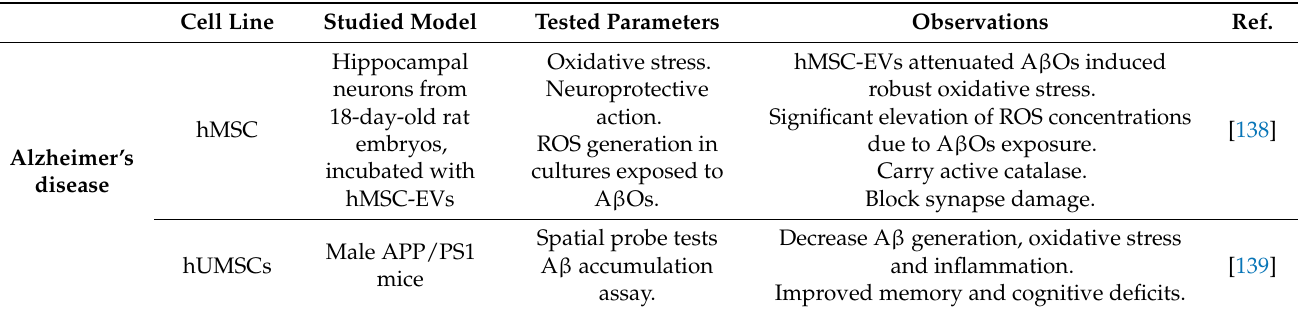
Table 2. MSC studies in chronic degenerative